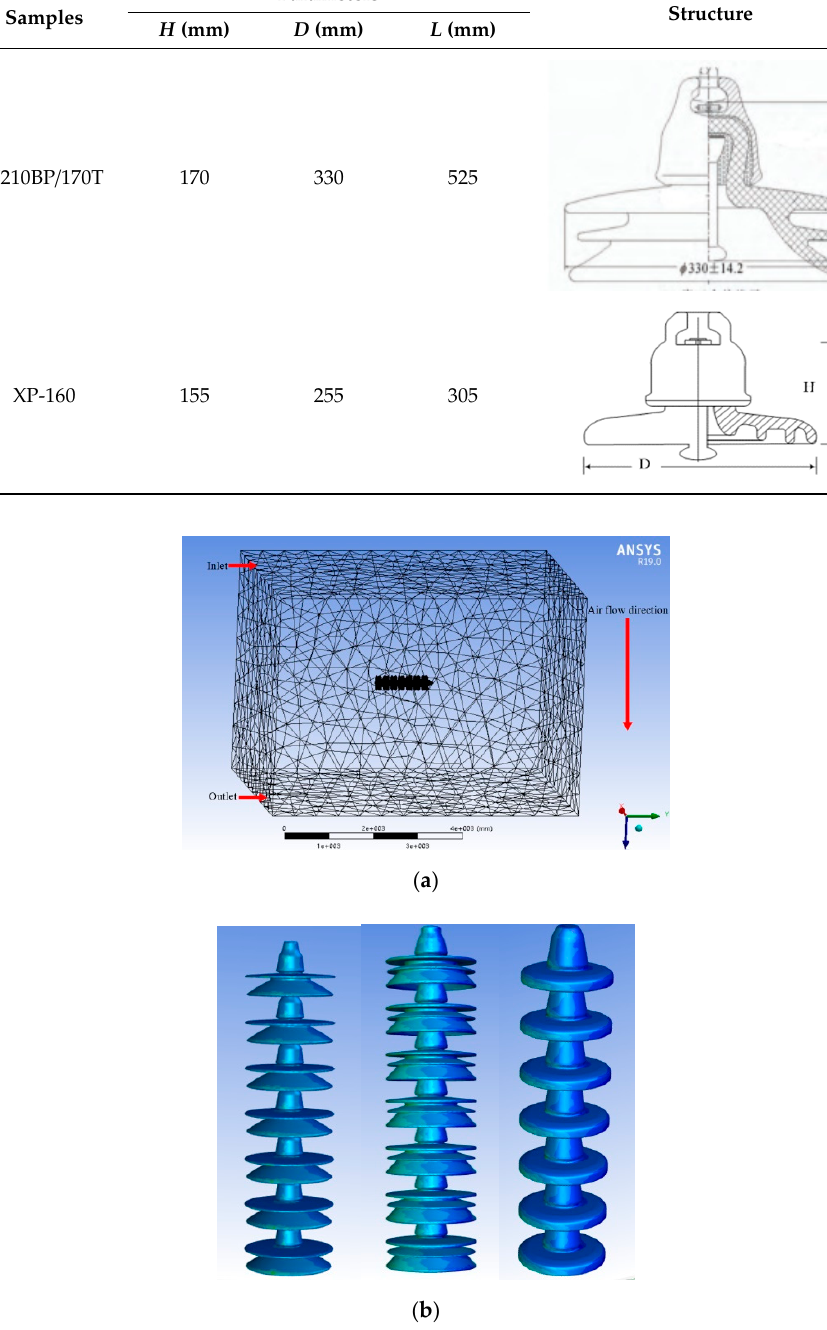
Figure 1. Calculation model and simulation results: ( a ) the calculation model in Ansys; ( b ) the simulation results of U210BP/170, U210BP/170 and XP-160.